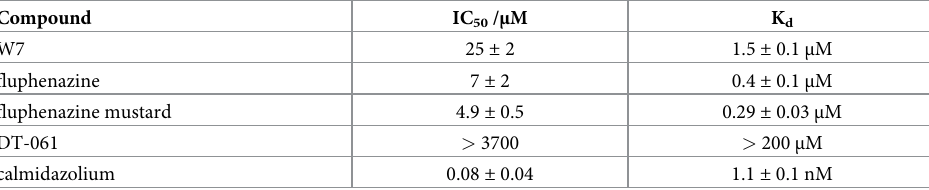
Table 1. CaM-binding affinity of compounds from fluorescence anisotropy data in Fig 2A (mean ± SD, n = 2).